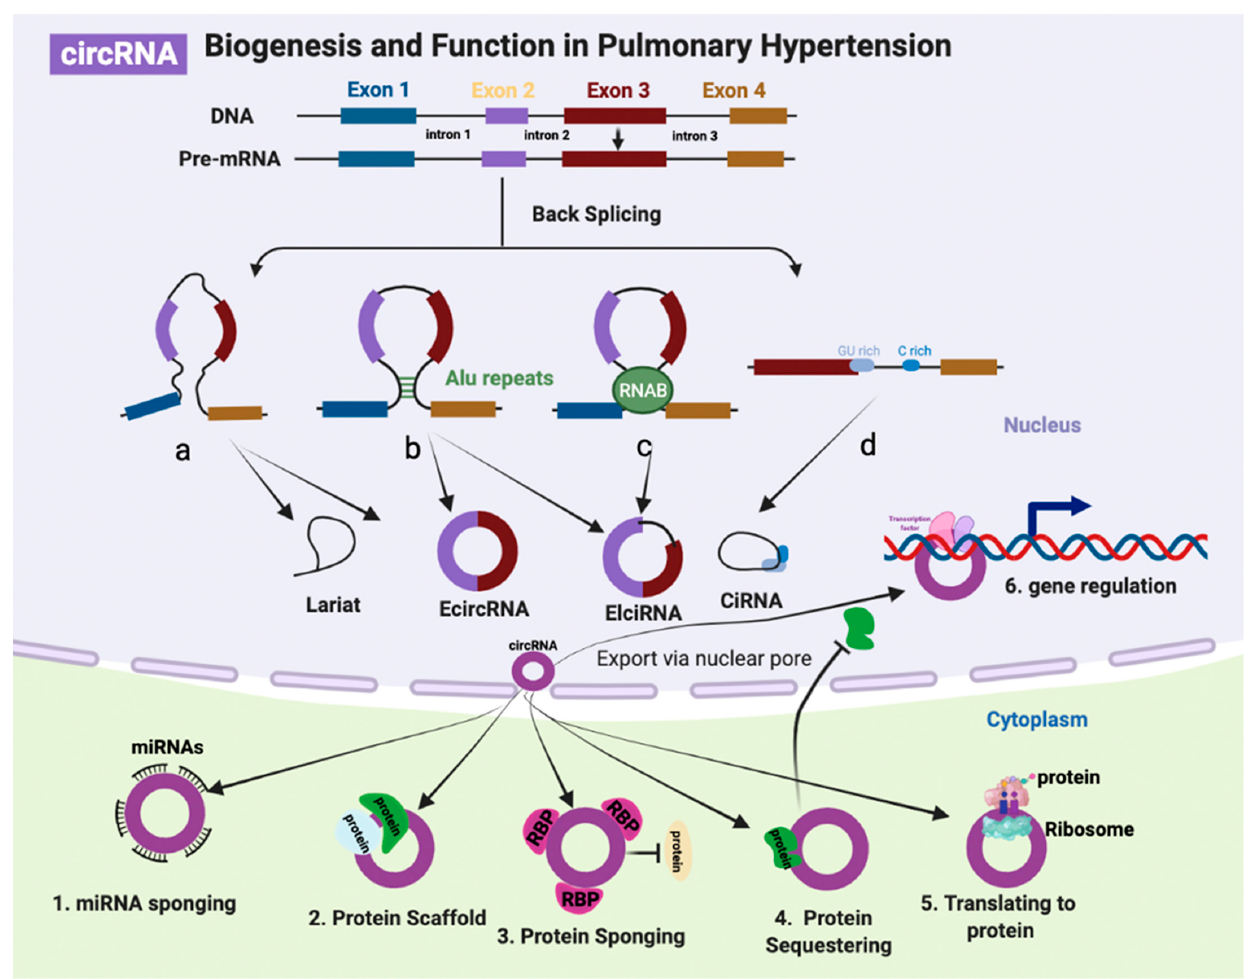
Figure 2. Biogenesis and functional mechanisms of circRNA. Schematic diagram showing biogenesis through canonical pre-mRNA splicing, yielding a mature mRNA molecule. ( a ) Lariat-driven circularization. ( b , c ) Back-splicing and circularization are medicated by RNA-binding proteins (RNAB) and Alu repeats. ( d ) ciRNA can form by some lariats removed from pre-mRNA via the canonical splicing mechanism. This process depends on a consensus motif containing a 7-nt GU-rich element near the 5 ′ splice site and an 11-nt-C-rich element close to the branchpoint site. Most circRNAs are exported to the cytoplasm, while few of them remain in nucleus after their biogenesis. The reported functional mechanisms include sponging miRNAs and RNA binding proteins (RBP) to decrease the binding availability of target mRNAs, assembling multiple proteins to form special protein complex, sequestering the protein in the cytosol, translating into peptide or protein, and transcriptional regulation of gene expression. The circRNAs in the diagram have been investigated in PH disease. Adapted from “circRNA in Cancer”, by BioRender.com (accessed on 25 Mar 2022) (2022). Modified from: https://app.biorender.com/biorender-templates (accessed on 25 Mar